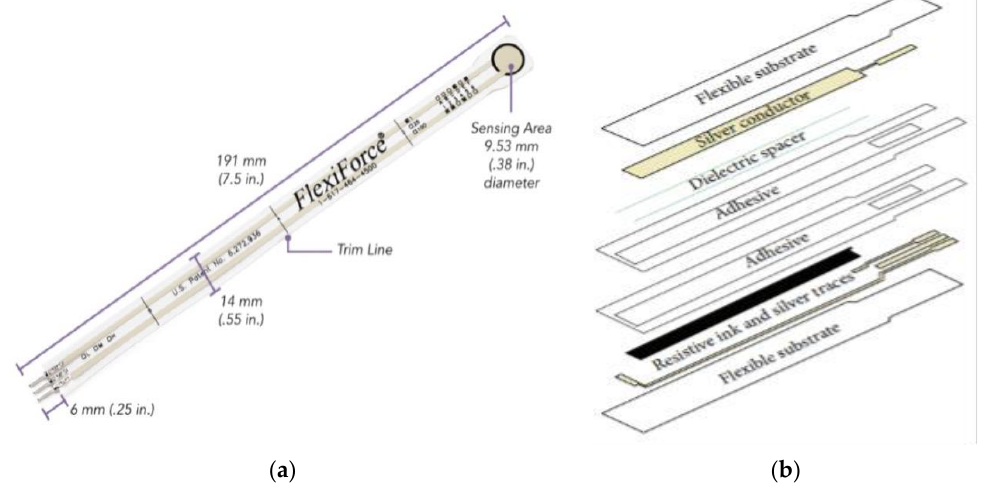
Figure 2. The FlexiForce ( a ) A201 unit ( b ) Components of the FlexiForce sensor [16].